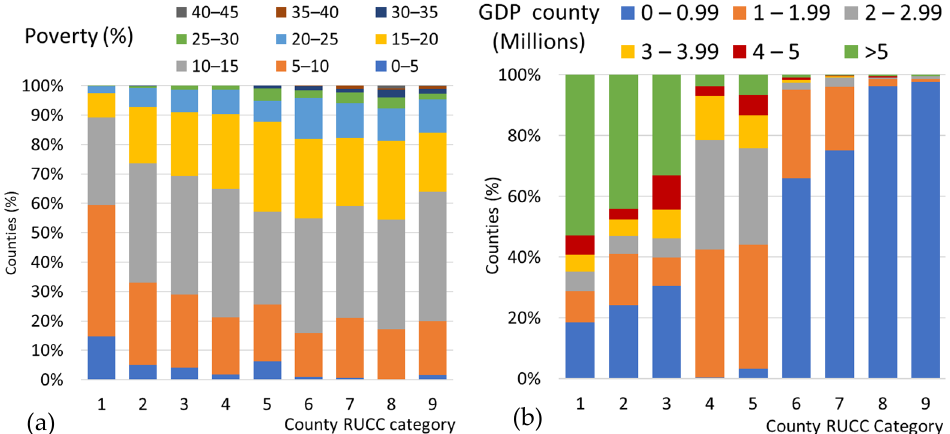
Figure 4. Counties economic activity and estimated poverty classified considering the USDA Rural– Urban Continuum Codes. ( a ) Poverty Estimates from USCB-SAIPE. ( b ) GDP per county from USDC-BEA.